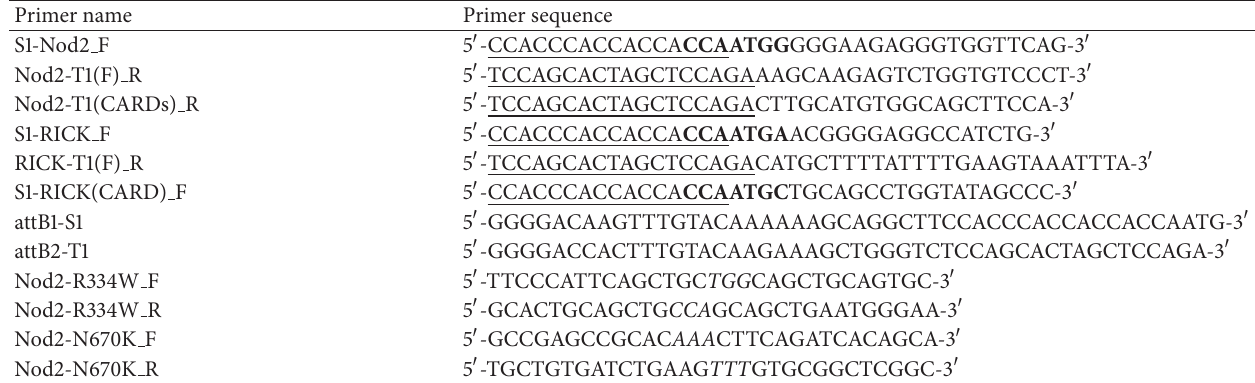
Table 1: Oligonucleotide sequences for plasmid